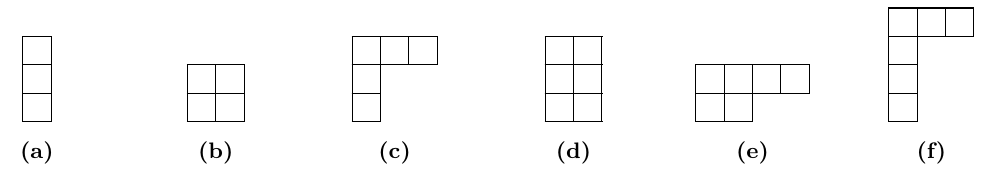
Figure 2. Young tableaux for the BCJ numerators at a) three-, b) four-, c) five-, and d,e,f) six-